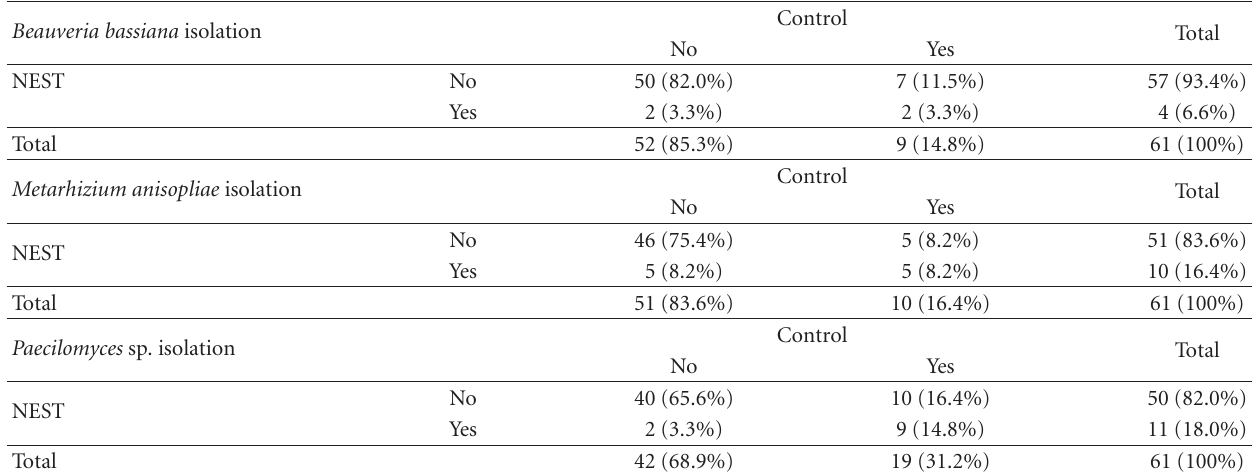
Table 4: Isolation of Beauveria bassiana, Metarhizium anisopliae, and Paecilomyces sp. inside ant nests and in soil control samples. Beauveria bassiana